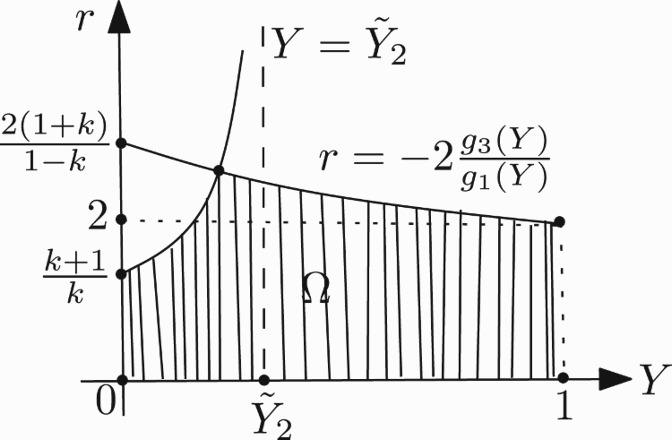
Shape of Ω in the case 0<k≤1.